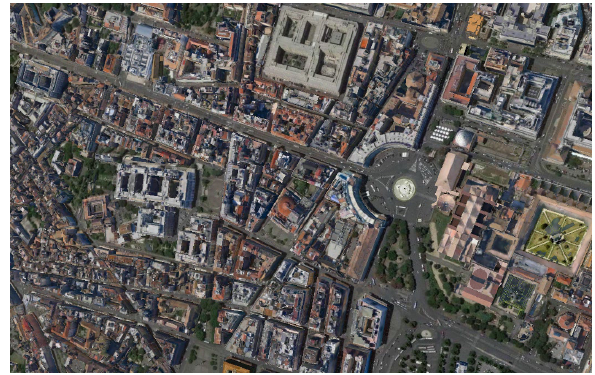
Figure 6: A snapshot from the sequence Roma, as simulated in Google Earth, with a 1088x672 resolution.